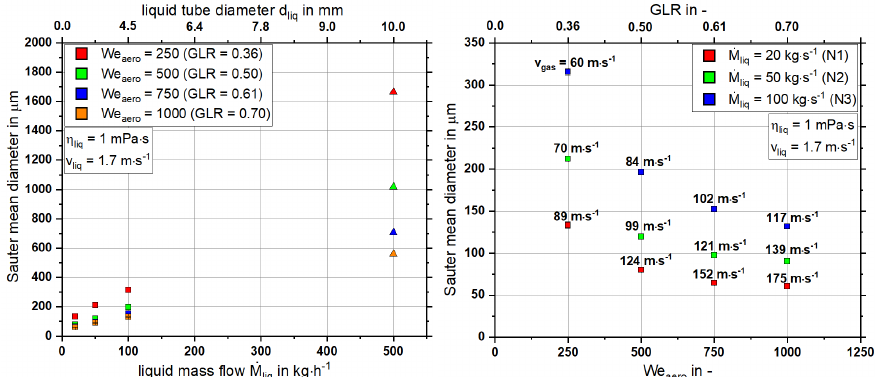
Figure 5. Integral Sauter mean diameter for varying liquid mass flow (or liquid tube diameter) ( left ) and aerodynamic Weber number (or GLR) ( right ); symbols: (cid:3) stands for data from PDA, (cid:52) represents data from high-speed camera.